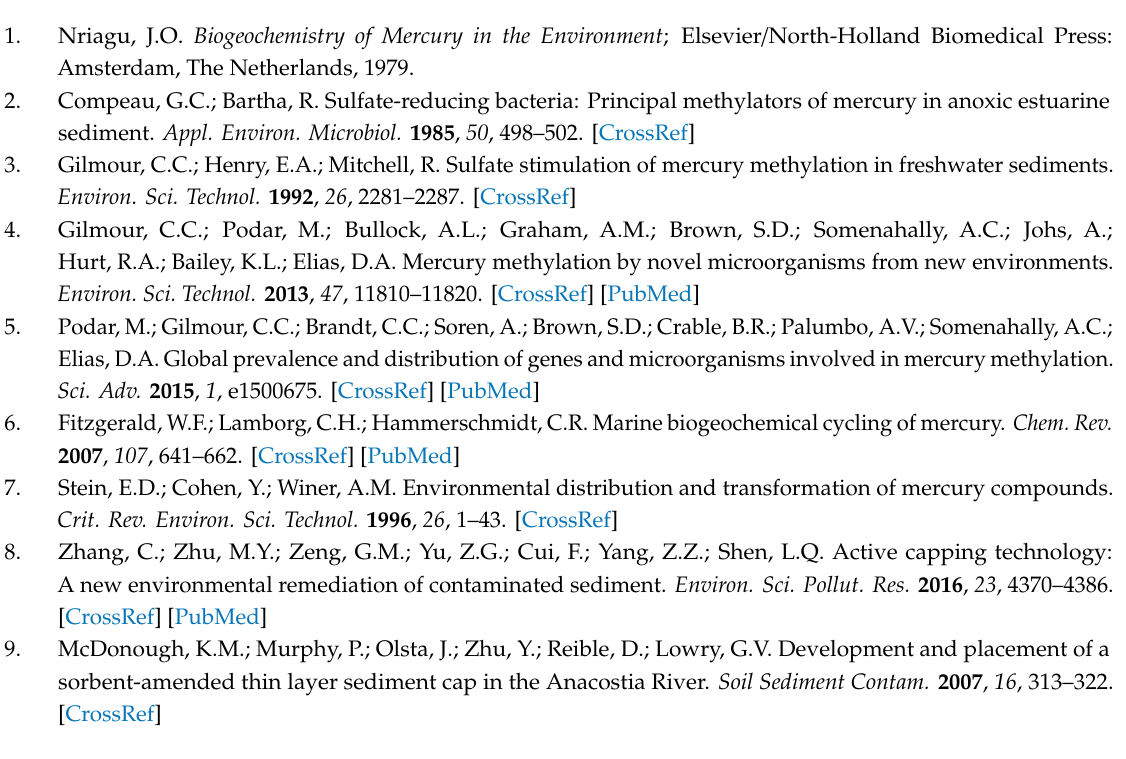
Table S1. Freshwater and seawater ion species concentration, Table S2. Hg(II) speciation at various salinity levels, Table S3. The partitioning coe ffi cients for Hg adsorptions at various salinity levels, Table S4. A one-way ANOVA or one-way ANOVA on ranks based on normality test, followed by a post hoc test ( p < 0.05) used to determine the significance di ff erences among various sorbents, Figure S1. Photos of the microcosms on (a) day 25 as the capping materials were initially applied and (b) on day 65, Figure S2. An-Shun site sediment texture, Figure S3. The temperature of microcosms (the symbol F refers to freshwater system and the symbol E refers to estuary system), Figure S4. The dissolved oxygen for the microcosms (the symbol F refers to freshwater system and the symbol E refers to estuary system), Figure S5. The pH value variation of microcosms (the symbol F refers to freshwater system and the symbol E refers to estuary system), Figure S6. The electricity conductivity of overlying water in (a) freshwater system and (b) estuary system, Figure S7. The oxidation reduction potential of overlying water in (a) freshwater system and (b) estuary system, Figure S8. DOM variation of microcosms for (a) freshwater system; (b) estuary system, Figure S9. The total Fe variation of microcosms in (a) freshwater system and (b) estuary